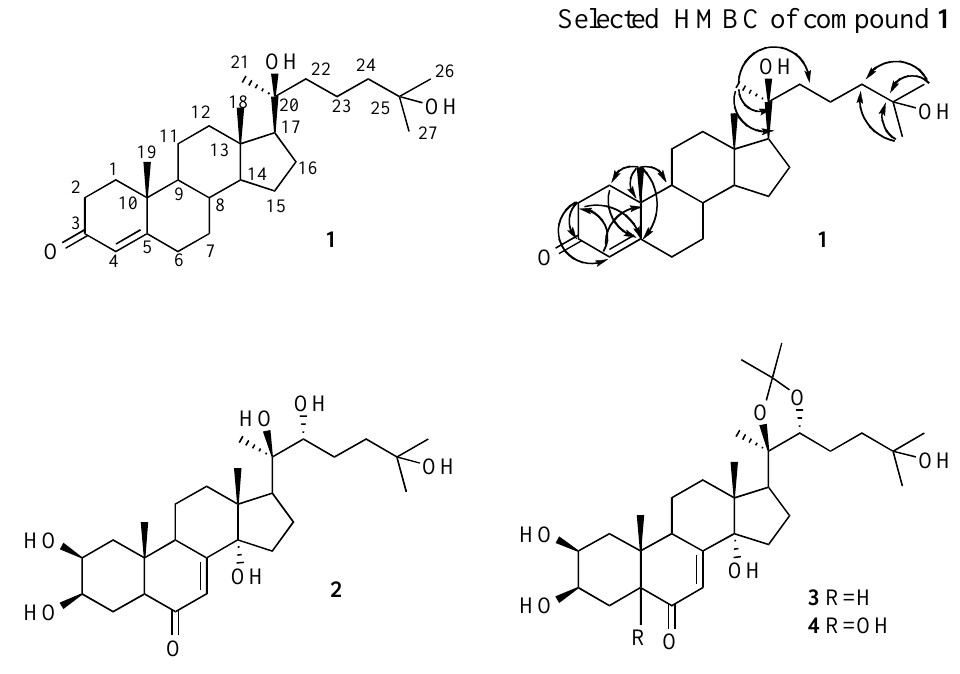
Figure 1. Structures of compounds 1,2,3 and